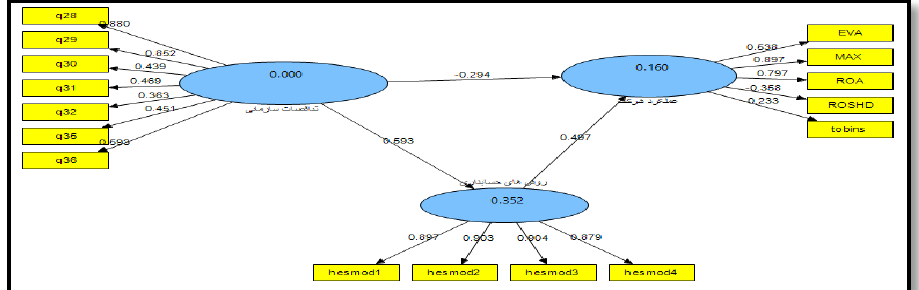
Figure 7. The model path